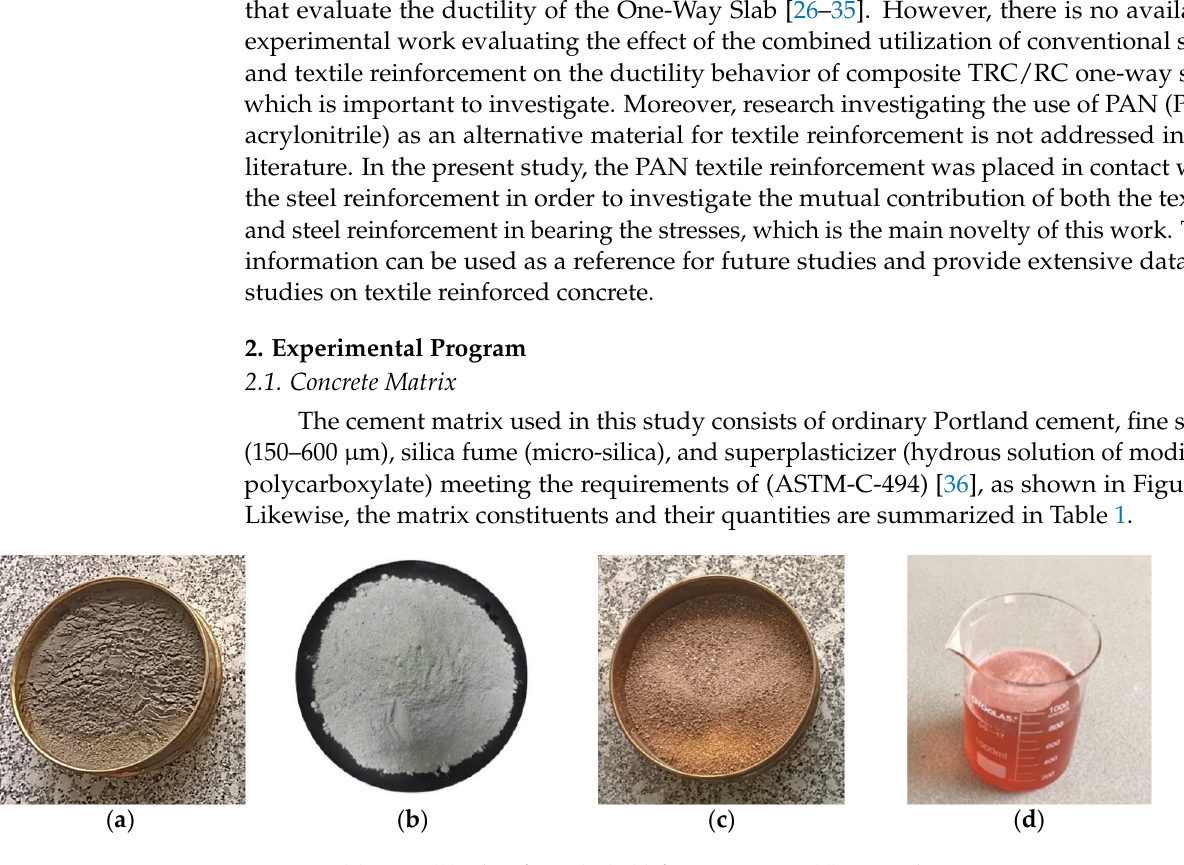
Figure 1. ( a ) OPC. ( b ) silica fume (SF). ( c ) fine aggregate. ( d )